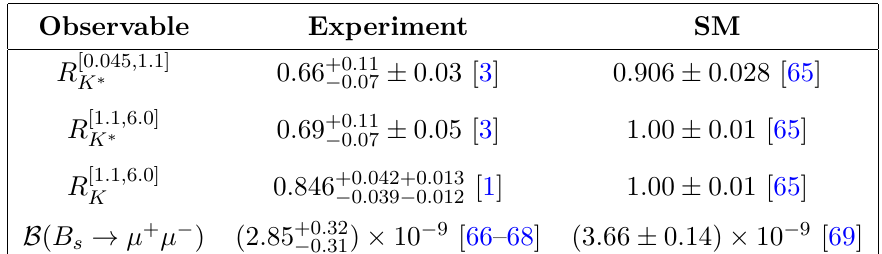
Table 1 . Experimental results and SM predictions for the clean observables in b → s‘ + ‘ − decays.